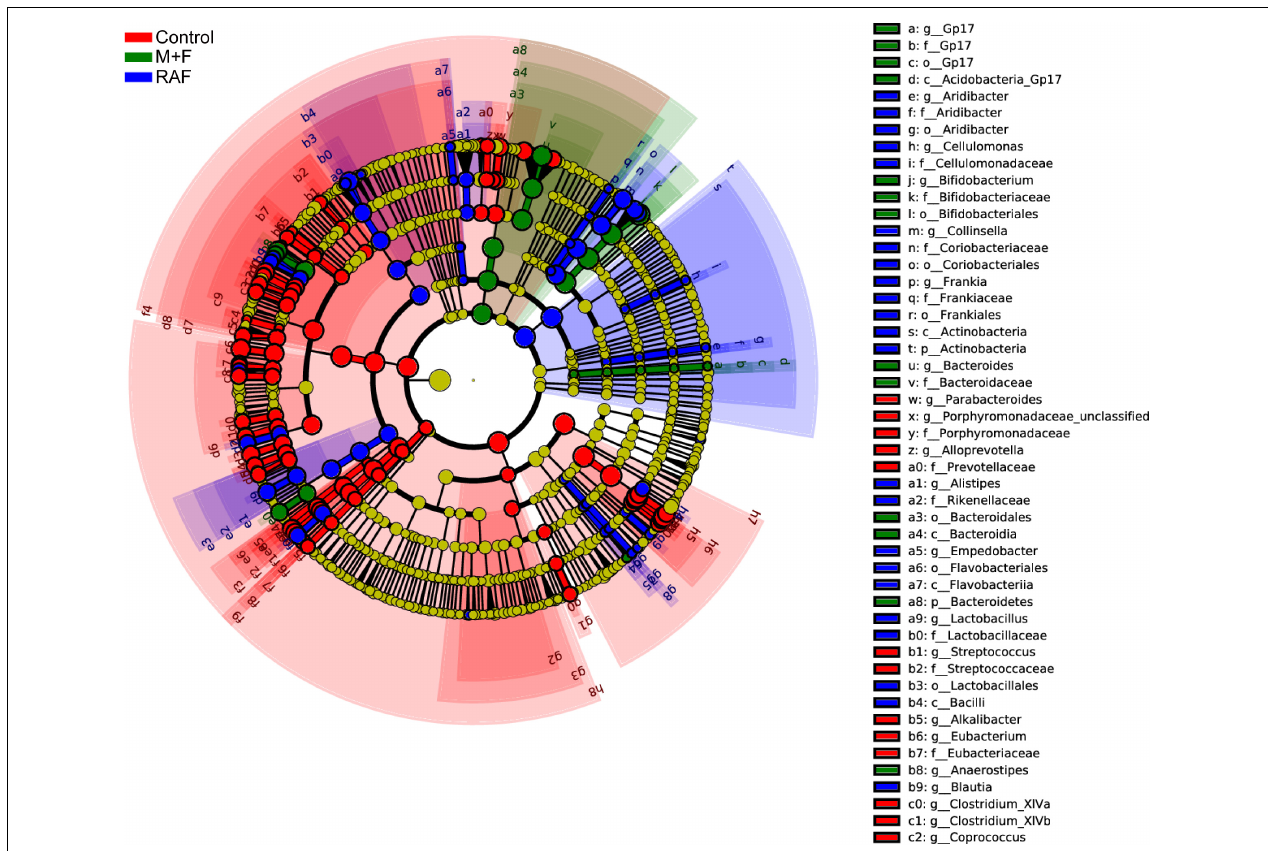
FIGURE 6 | Comparisons of microbiota among Control, soymilk (RAF), and InvDz13-treated soymilk (M + F) groups based on linear discriminant analysis effect size (LEfSe). Taxa enriched in microbiota from Control (red), RAF (blue), or M + F (green) were indicated with a positive LDA score, respectively, (taxa with LDA score > 2 and significance of α < 0.05 determined by Wilcoxon signed- rank